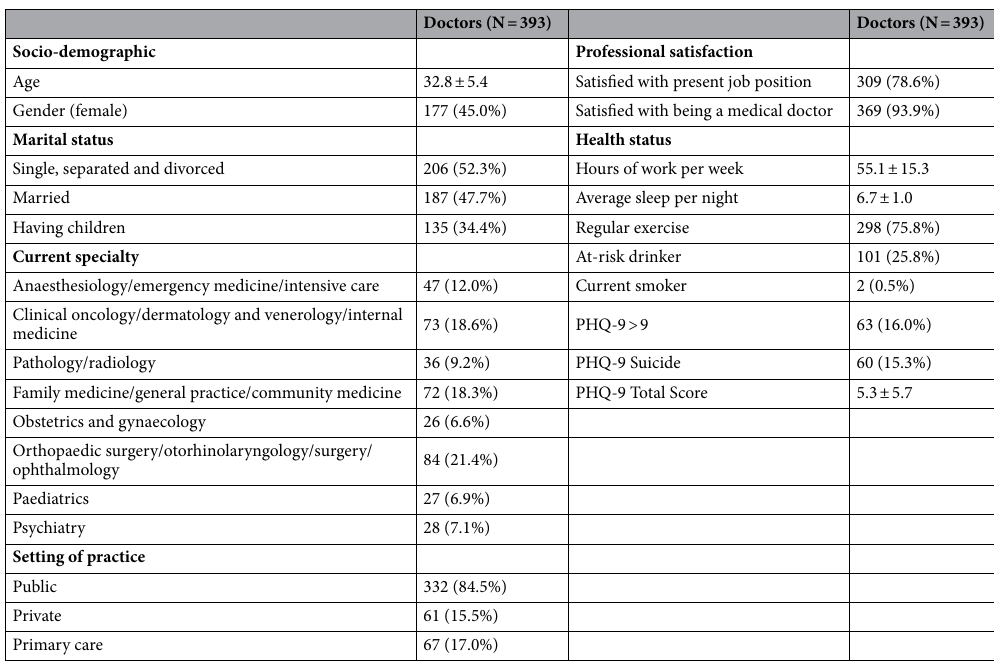
Table 1. Descriptive statistics on sociodemographic, professional satisfaction and health status. Current smoker (Current smoker vs non-smoker/ex-smoker). At-risk drinkers were defined if the doctors had 3 or more in AUDIT-C score. Private Practice (Private Solo/ Private Hospital/Non-government organisation). Public Practice (University/Government/Hospital Authority/Not applicable). Regular exercise (5 or more days per week for at least 10 min per day / Any vigorous and moderate physical activities) All data are represented in mean ± SD or total (%), as